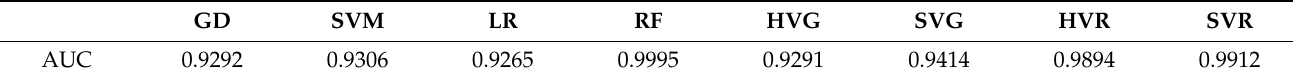
Figure 11. Standard ROC curve. Table 5. AUC scores for model selection algorithms GD, SVM, LR, RF, HVG, SVG, HVR, and SVR.